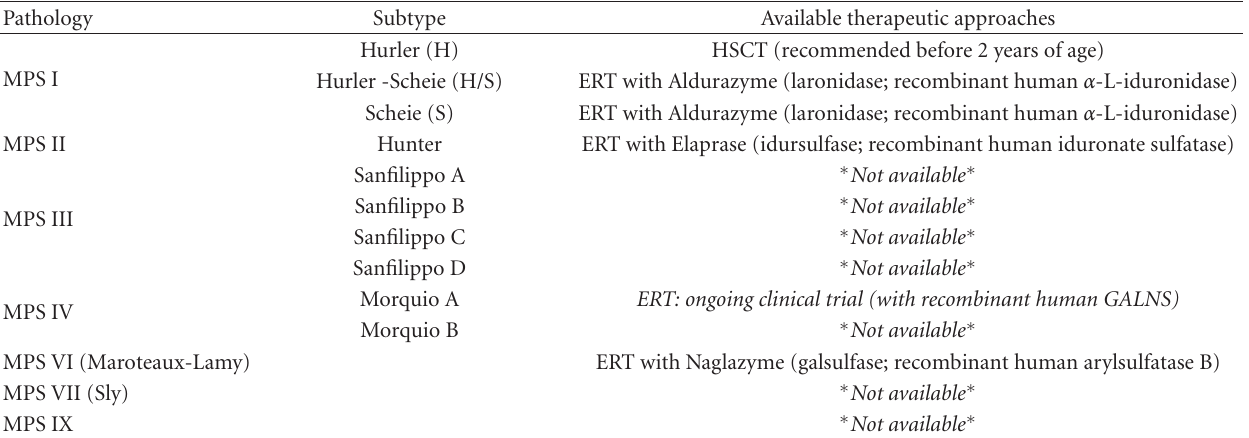
Table 2: Available therapeutic approaches for